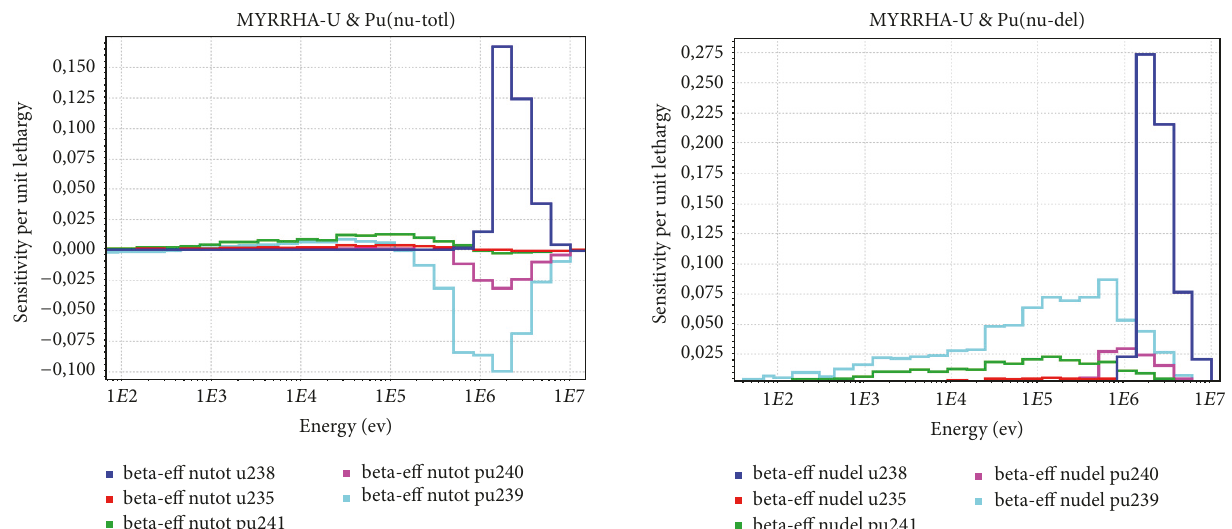
Figure14:Sensitivityof 𝛽 eff tothetotalneutronyieldof 235 U, 238 U, 239 Pu, 240 Puand 241 PucalculatedusingtheSUSD3DcodefortheMYRRHA